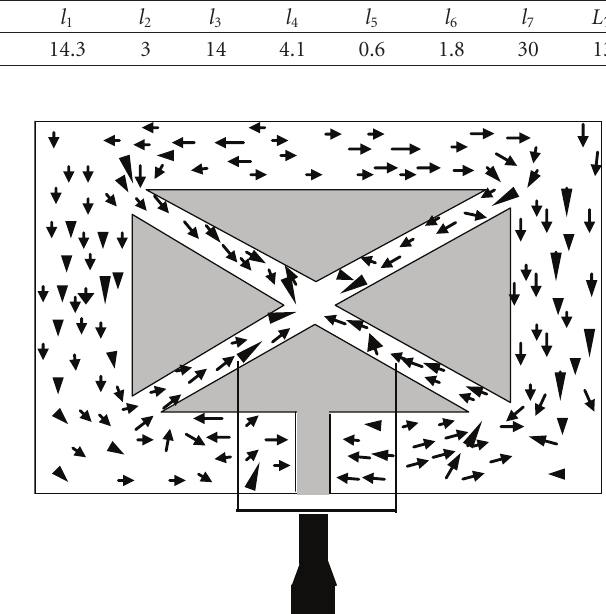
Table 1: The dimensions of proposed antenna to mm.